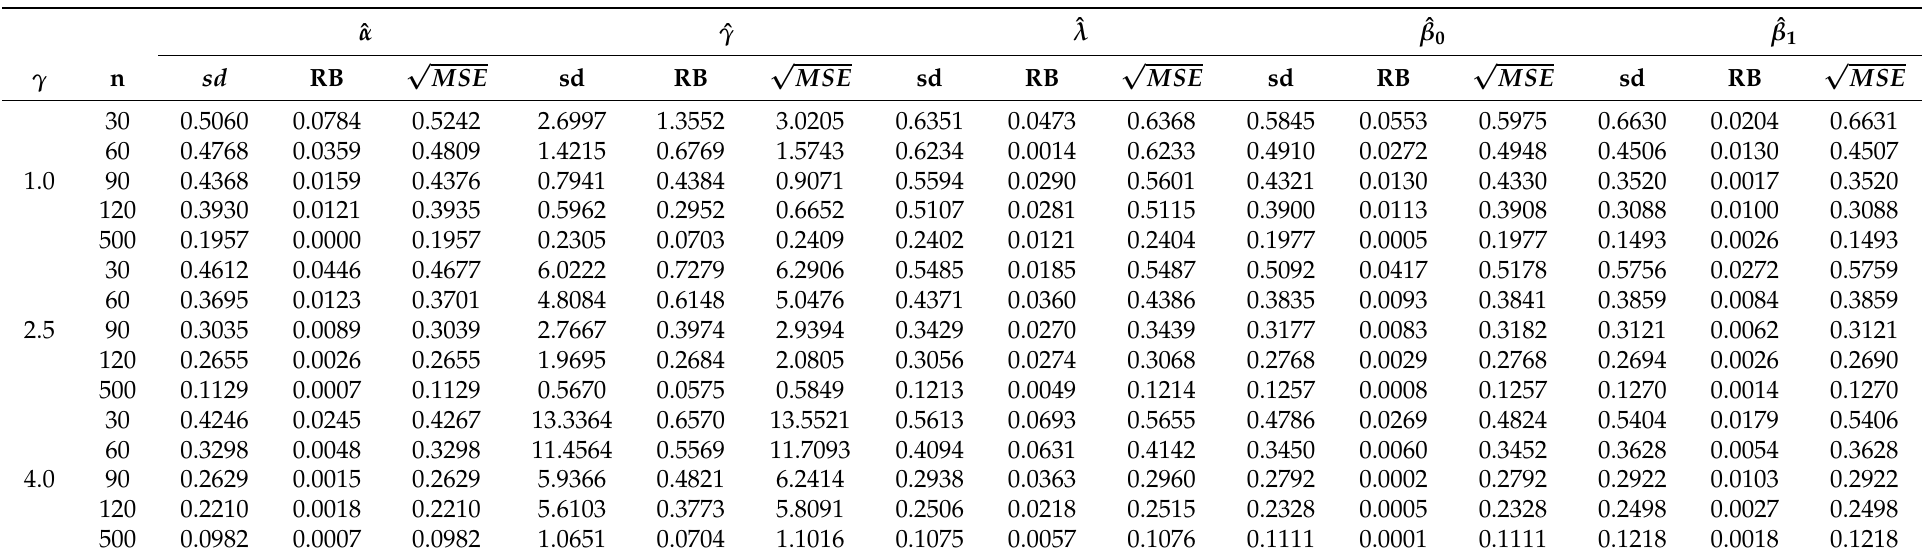
√ MSE for the EGSHN ( 1.75,2.25,0.75, γ ,1 )